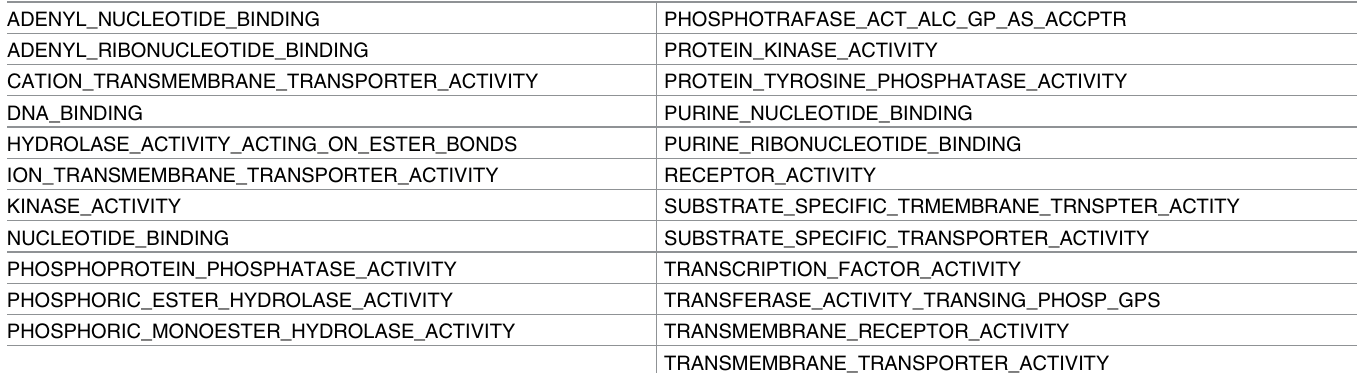
Table 3. Pathways shared in the GSEA results for erlotinib and